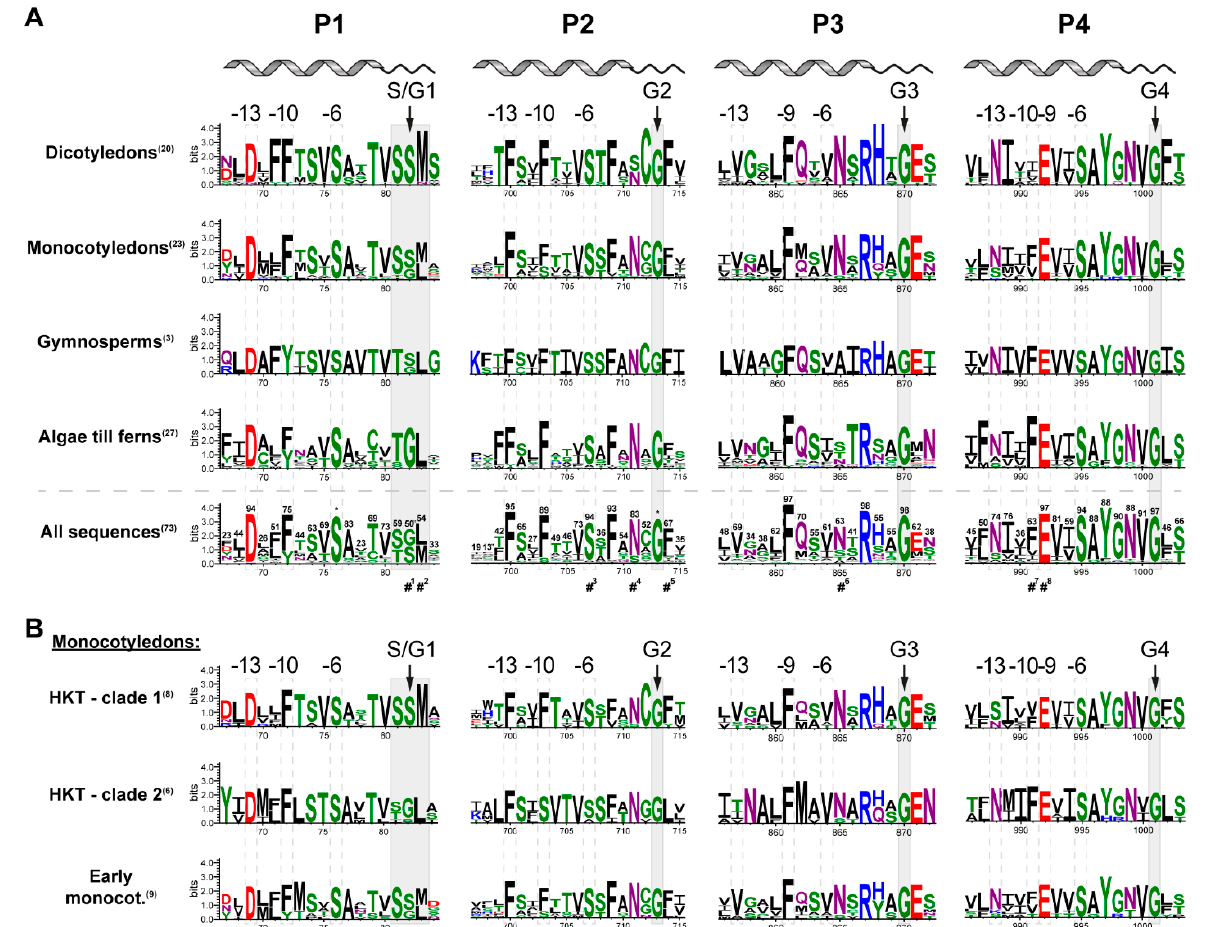
Figure 2. Motifs and conserved amino acids in HKT channel pore regions. Sequence logos based on 73 sequences used for the multiple sequence alignment in Figure S2 and the phylogenetic tree in Figure S1 were generated by WebLogo 3.7.4 [42,43]. ( A ) Logos of the four pore domains P1–P4 for sequences of algae to ferns, gymnosperms, monocotyledons, dicotyledons, and all 73 sequences together. The illustration above the sequence logos represents an approximation of the secondary structure of each pore domain, indicating the pore helix and pore loop. Numbers in parenthesis next to the names of evolutionary groups indicate the number of sequences used for the generation of the logos. Please note that the sequence logo for gymnosperms was generated with only three sequences. For the sequence logos based on all sequences, the percentage of the most frequent amino acid per position is indicated. Numbers above amino acids are percentages. The asterisk indicates residues with 100% presence in all structures. A quotation mark (”) indicates that two amino acids appeared with the highest frequency in the alignment (e.g., 50” indicates that the two most frequent amino acids each appear in 50% of the sequences). S/G1, G2, G3, and G4 indicate the selectivity filter residues. A motif switch in P1, including the selectivity filter residue, is shaded, as well as the selectivity filter residues in P2 to P4. Dashed boxes mark amino acids six, nine or ten, and thirteen positions upstream of selectivity filter residues. Residues are coloured according to their chemical properties: polar residues (G, S, T, Y, C) in green, neutral residues (Q, N) in purple, basic residues (K, R, H) in blue, acidic residues (D, E) in red, and hydrophobic residues (A, V, L, I, P, W, F, M) in black. The number signs below the logos indicate positions for which mutations are available. Mutations are described in the following references: #1 [7], #2 [7], #3 [2], #4 [44], #5 [2], #6 [45], #7 [41], #8 [41]. ( B ) Sequence logos of the four pore regions specified for early angiosperms, class I, and class II HKTs. Highlights as in